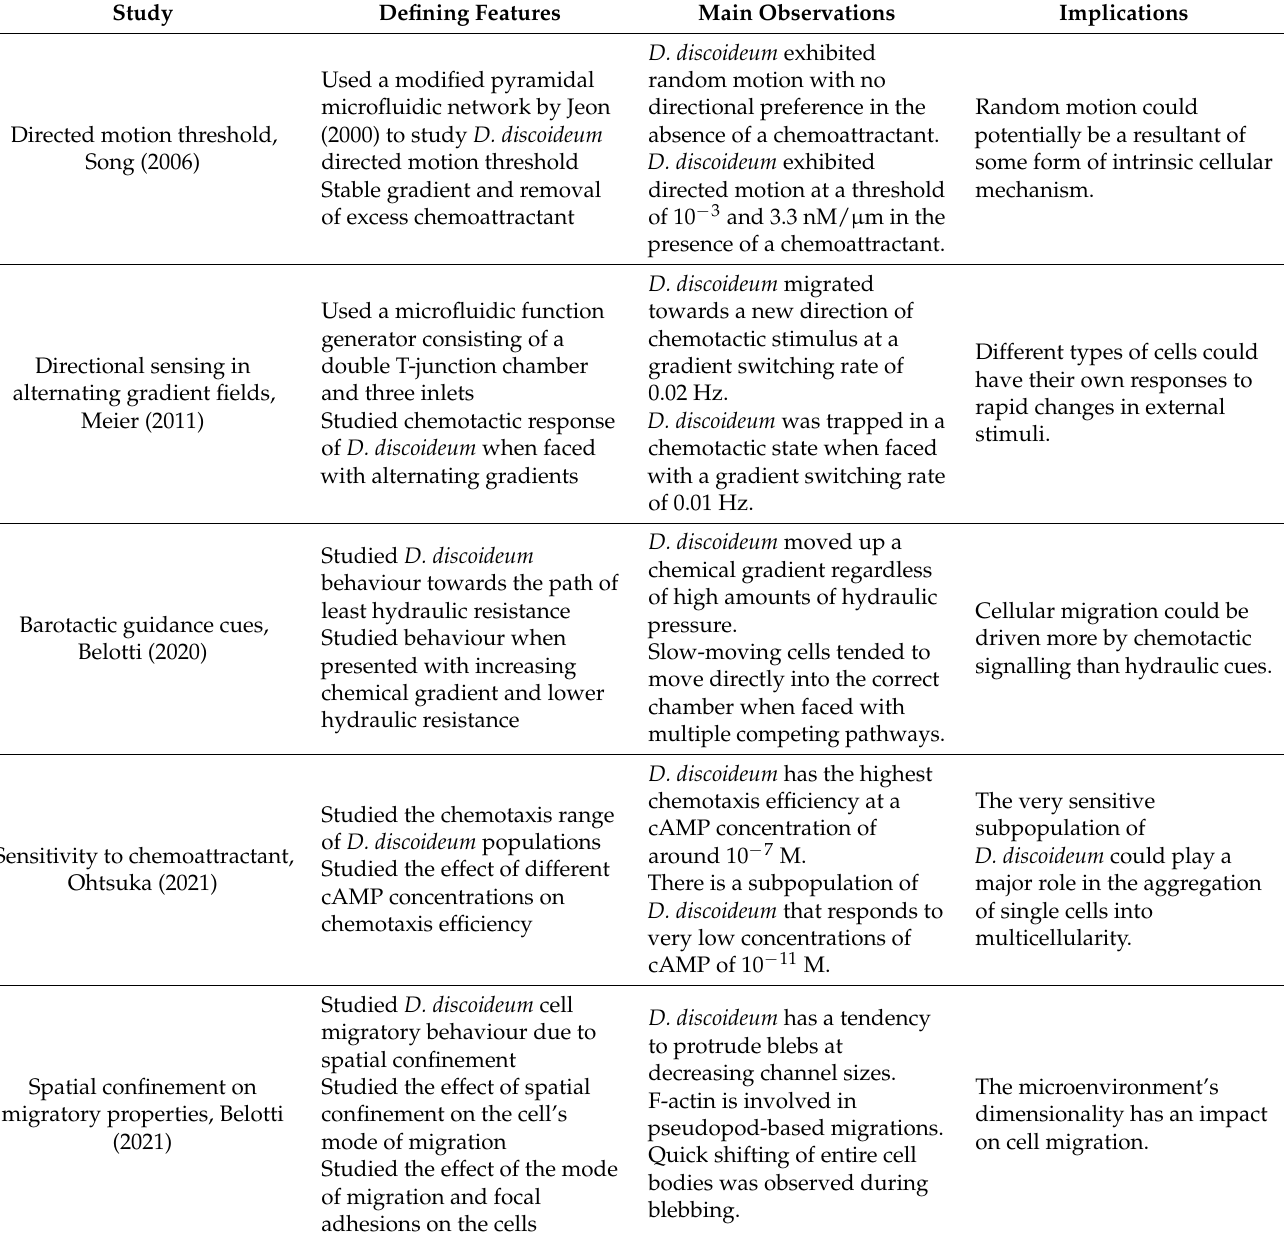
Table 2. Studies on Dictyostelium discoideum chemotaxis that took advantage of microfluidic technol- ogy as well as their